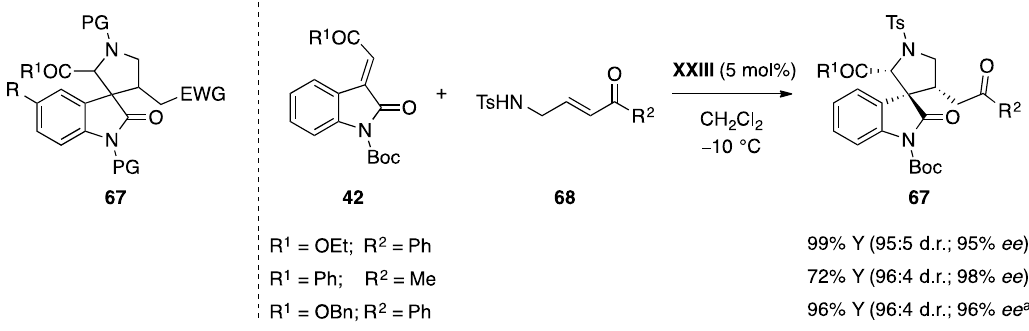
Figure 6. Squaramide based organocatalysts reported in the present